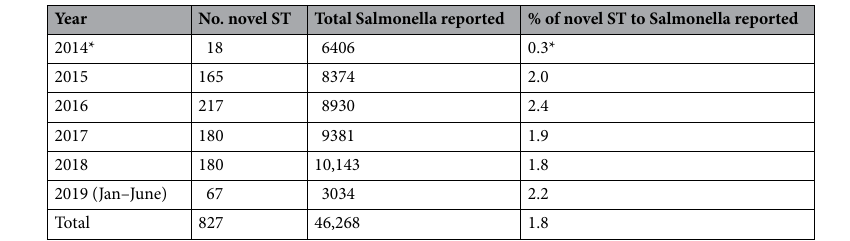
Table 2. Number of Novel STs identified each year at PHE. *Automated Novel ST pipeline implemented in 2015 so Novel STs underrepresented in 2014 in this analysis.